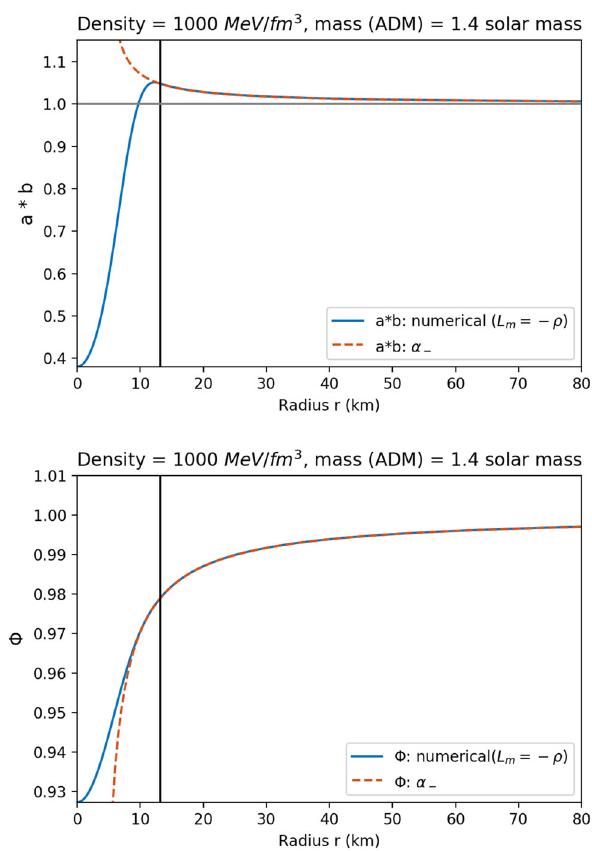
Fig. 1 Comparison of the product of the metric components and the scalar field between the analytical solution α − and the numerical solu- tion for L m = − ρ , and ρ 0 = 1000 MeV / f m 3 . The vertical line indi- cates the radius of the compact